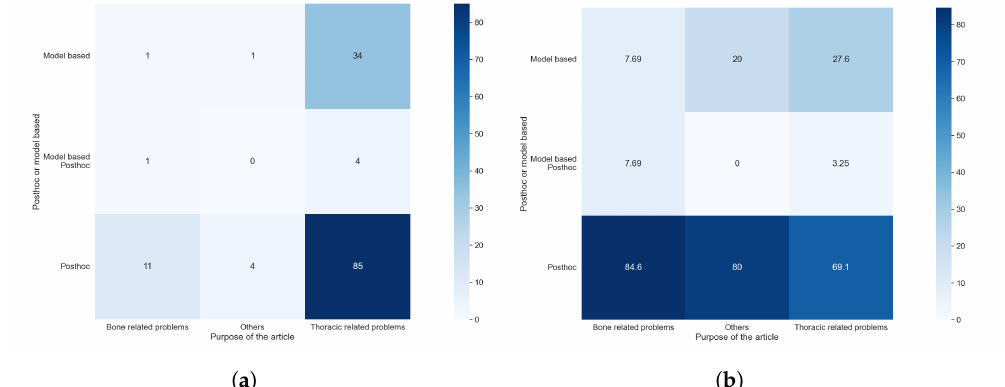
Figure 15. Heat maps comparing the results of RQ1 and RQ6. ( a ) In absolute values; ( b ) normalized results by